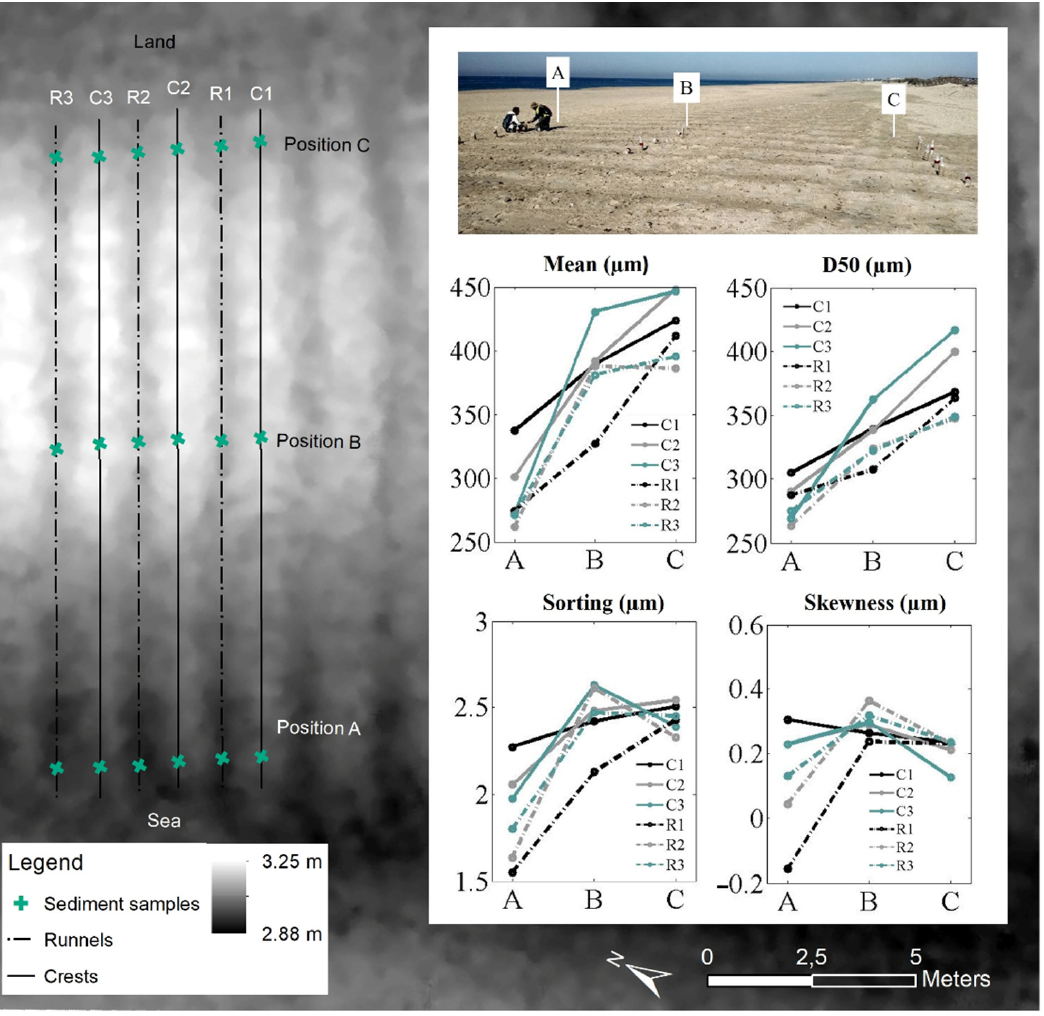
Figure 5. Left: sketch showing the location of the sediment samples as well as the position of the crests and runnels (background image: October 2017 DEM). Right: statistical parameters obtained from the grain-size analyses in GRADISTAT.